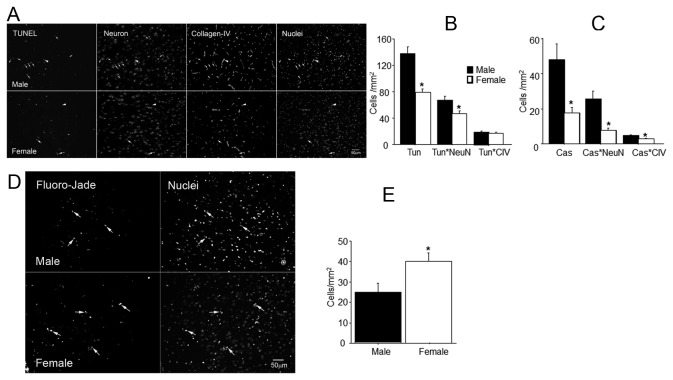
Cell death.Activated caspase-3 immunoreactivity and TUNEL staining 3h after SAH. Panels A-B: 4-color fluorescence staining for TUNEL, NeuN, collagen-IV, and DAPI. Panel A: typical micrographs from male and female SAH animals. Each channel is shown as a separate image. Small arrows: TUNEL-positive neurons; large arrowheads: TUNEL-positive vascular cells. Note the greater frequency of TUNEL-positive neurons in male as compared to female. Panel B: average numbers of TUNEL-only, TUNEL+NeuN, and TUNEL+collagen-IV profiles. TUNEL-only and TUNEL-NeuN profiles are significantly greater in males than in females. Panel C: average numbers of profiles positive for activated caspase-3 (Cas) only, Cas+NeuN, and Cas+collagen-IV. All three indexes are significantly greater in male animals. Panel D: Fluoro-Jade B-positive cells (arrows) in representative SAH male and female brain sections. Panel E: Average numbers of Fluoro-Jade B-positive cells in SAH animals. Data are mean ± sem from 5 animals per gender. * significantly gender difference (p <0.05).